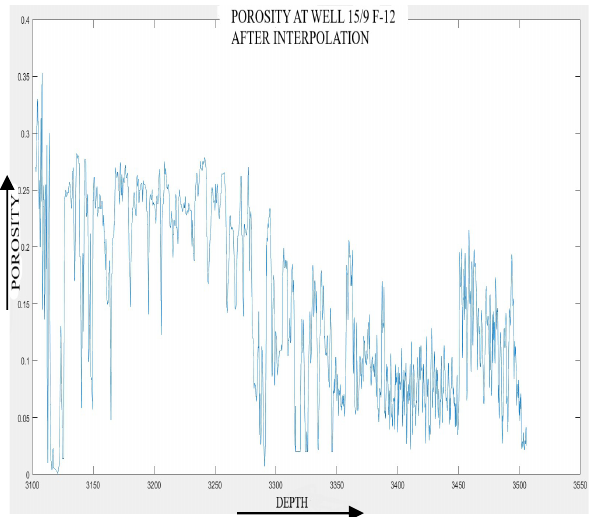
Figure 4. Interpolated porosity(y-axis) at well 15/9 F-12 concerning the depth in km(x-axis). Figure 5. was obtained using scattered interpolant object with the nearest neighbour method. Next, the authors fitted the generated results to the 3-D interpolation object and thus gained access to all the planes possible within the mesh-grid. Colour bar shows a range of porosity.